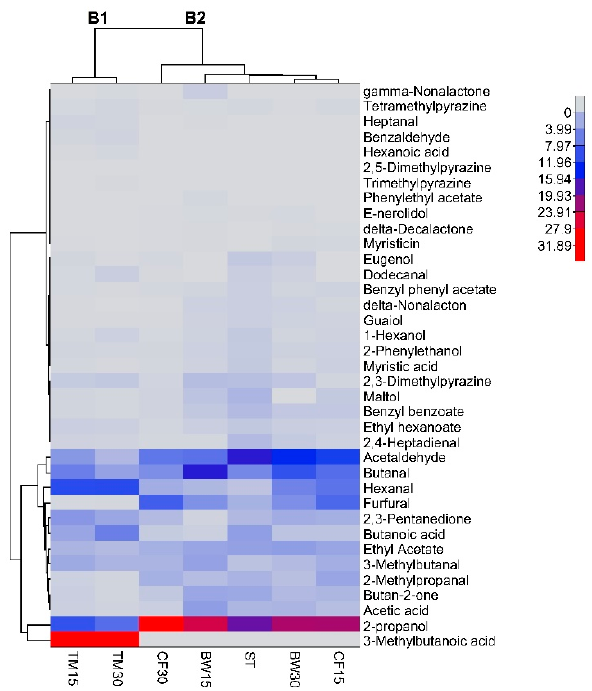
Figure 4. Heatmap showing the distribution and concentration of individual volatile compounds in bars.